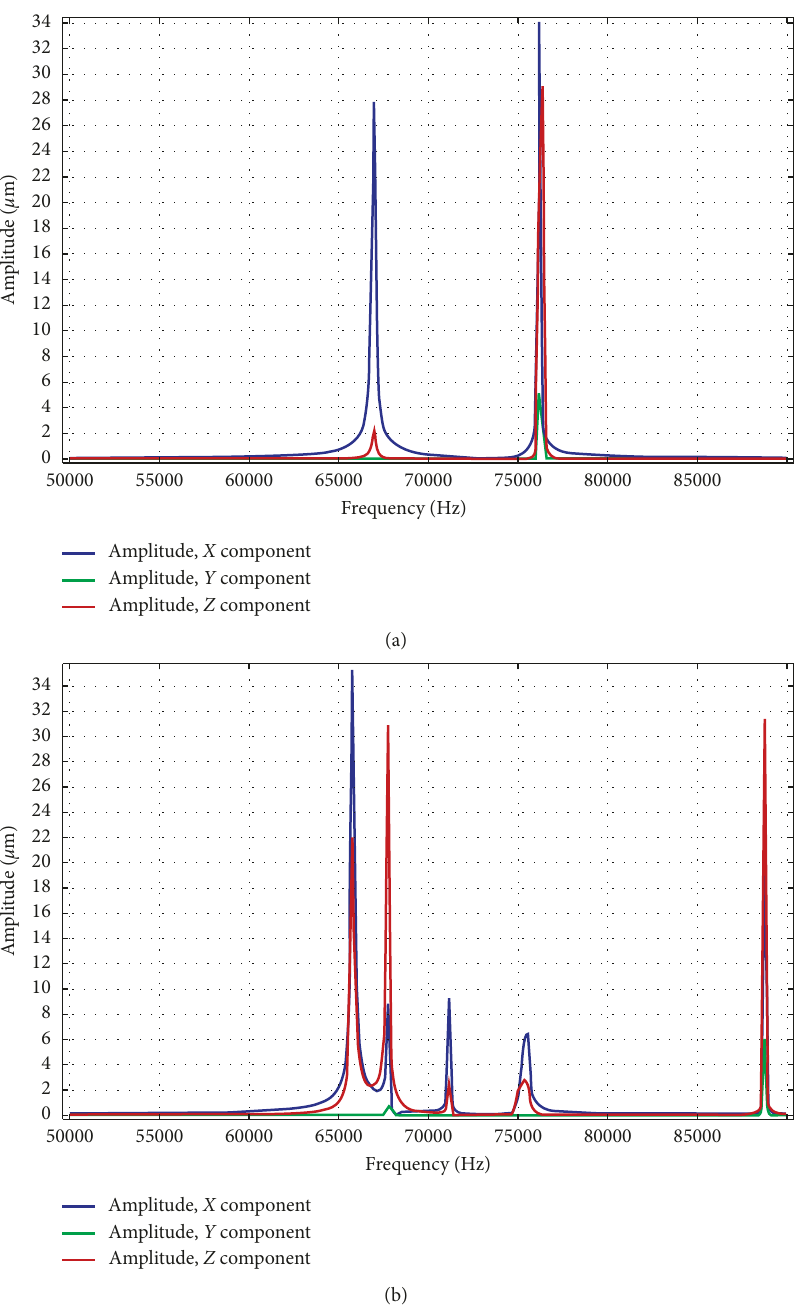
Figure 2: Amplitude-frequency characteristic of the contact points vibrations when the single electrode of the upper ring (a) and lower ring (b) is